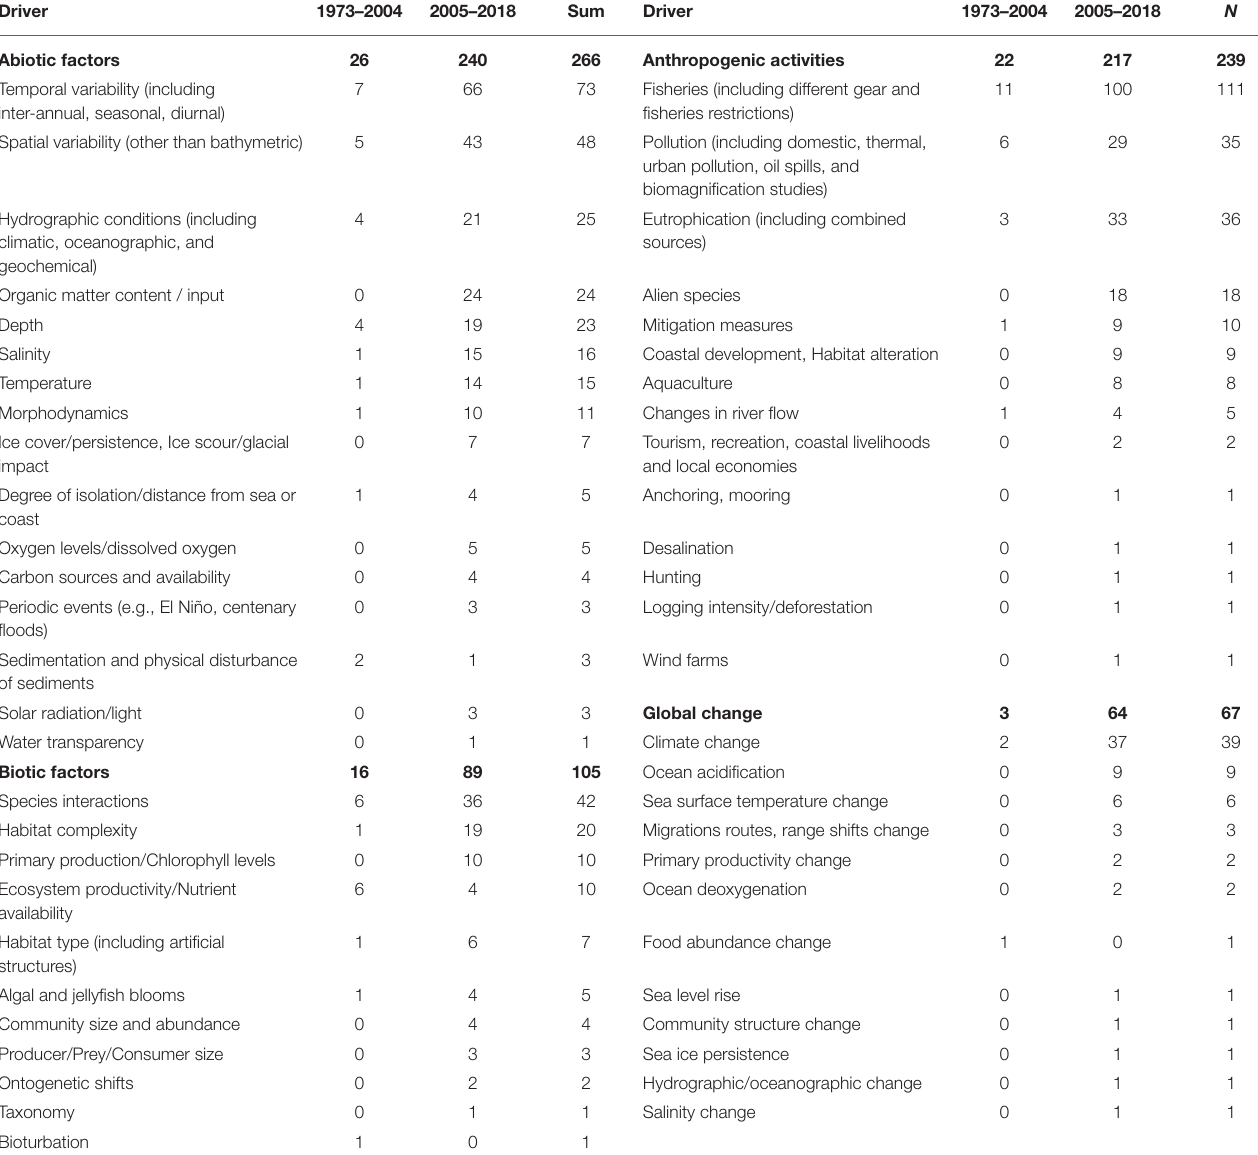
TABLE 1 | Analytical list of all the drivers considered in the food web studies analyzed in this